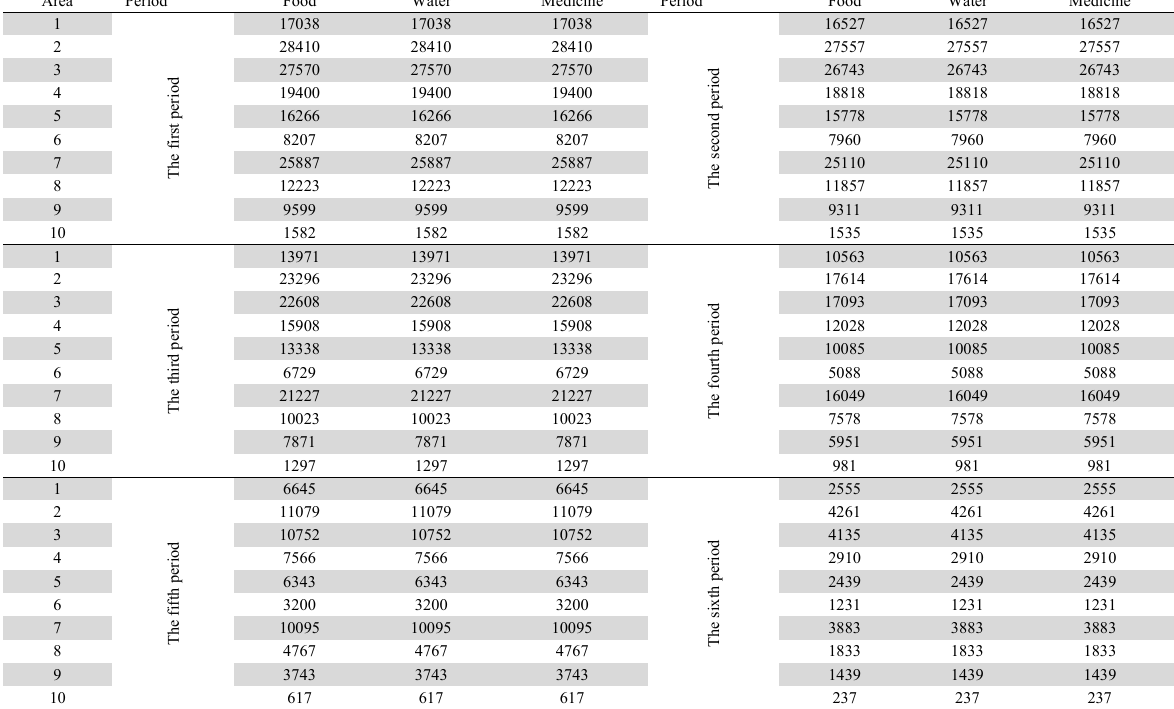
Demands for relief commodities of 10 areas in Tehran region 1 for 6 time periods